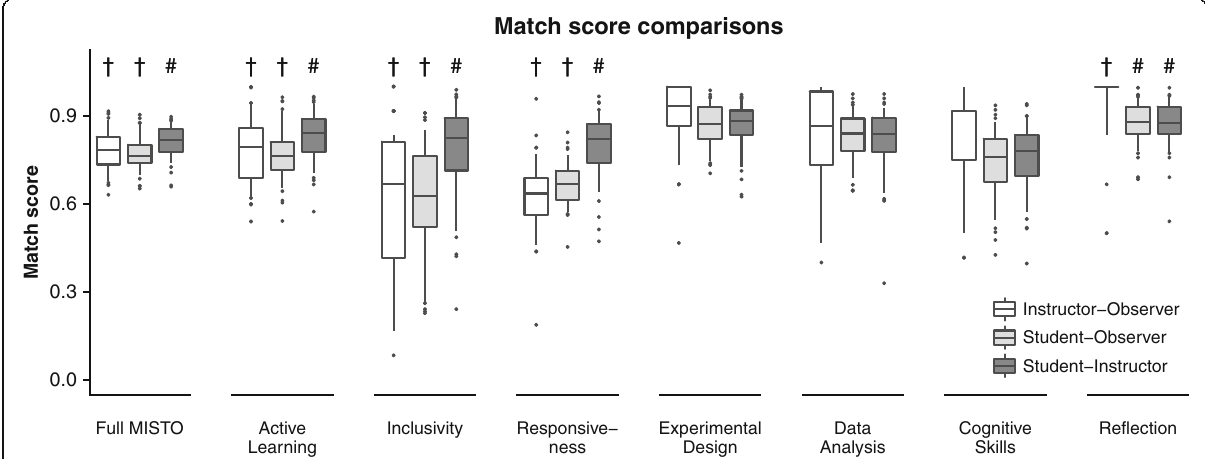
Fig. 5 Full MISTO and MISTO subcategory match scores comparing perspectives. Average item match scores among MISTO items on the full MISTO and on each MISTO subcategory. Box plots show the distributions of average MISTO and subcategory match scores for each course between two perspectives: instructor – observer comparisons (white boxes), student – observer comparisons (light gray boxes), and student – instructor comparisons (dark gray boxes); n =70 courses. Central bars represent median match scores, boxes reflect interquartile range, whiskers reflect the 5th and 95th percentile range, and dots represent data points outside this range. Different symbols represent significant differences between perspectives within the full MISTO or within each MISTO subcategory, as determined by ANOVA with pair-wise post hoc Tukey tests